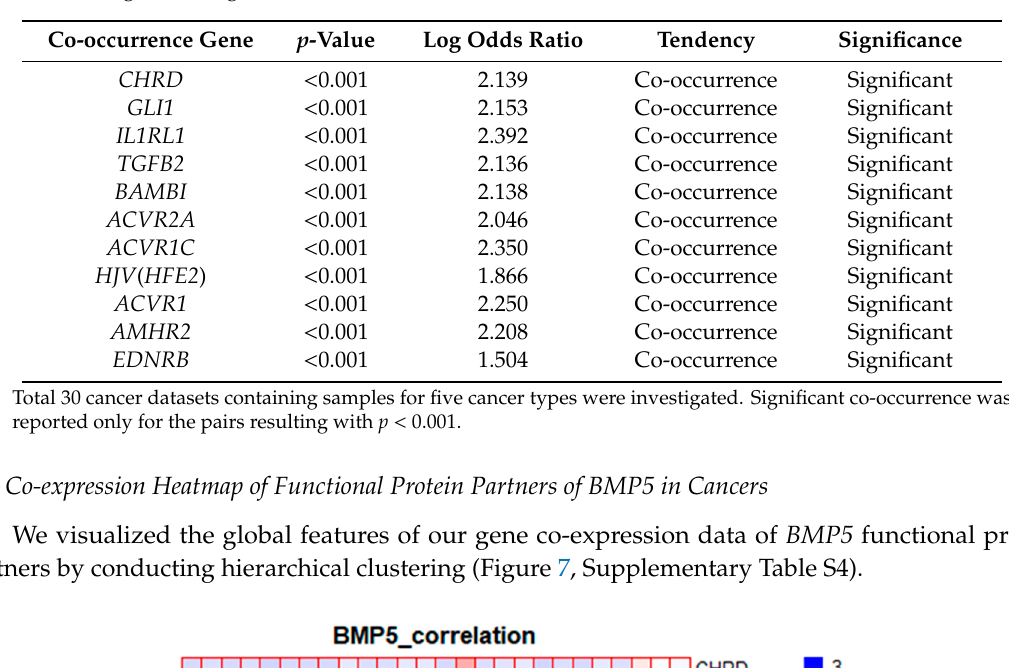
Table 2. Mutual exclusivity analysis reporting co-occurrence of alterations in the BMP5 gene signature was investigated using cBioPortal for Cancer Genomics.